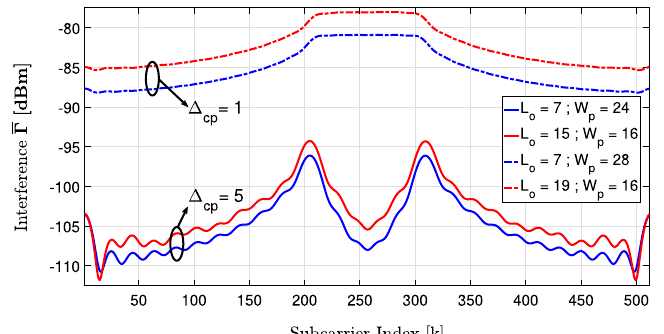
7 , 5 for ( L o = = 19 , W p 16 ) = =